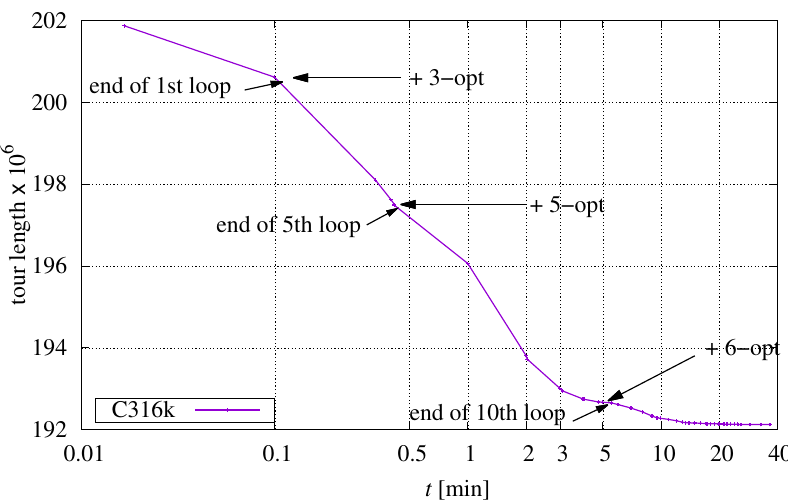
Figure 8. Progress of optimization exemplified on instance C316k.0 and preliminary settings. The initial tour with a length of 201 871 162 is provided by DoLoWire (30 s). After an initial loop over all points P using 2-opt permutations according to Section 2.4.1, the tour length is reduced to 200 615 308 by 3845 successful permutations. This reduction is possible because DoLoWire does not optimize the initial tour across cluster boundaries.